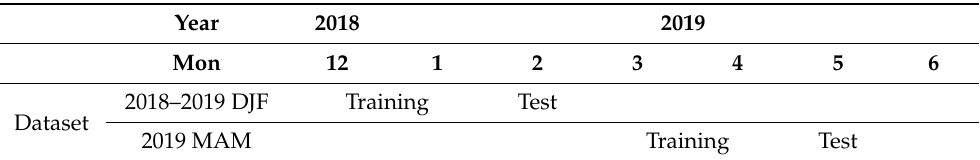
Table 2. Training period and test period for each